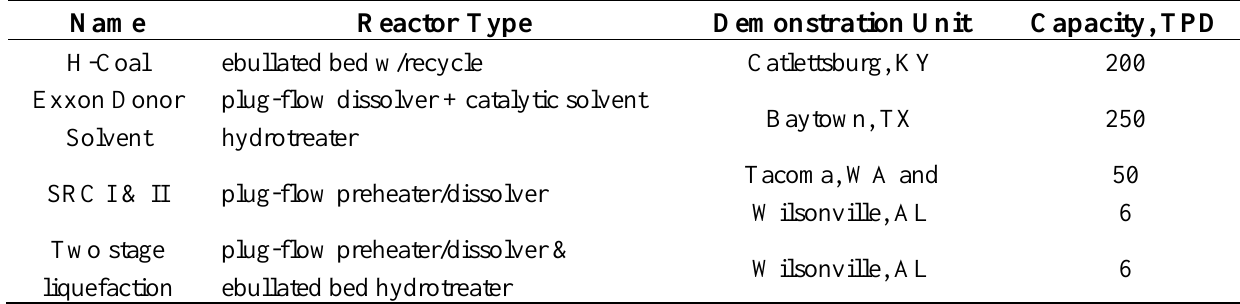
Table 1. Coal liquefaction process